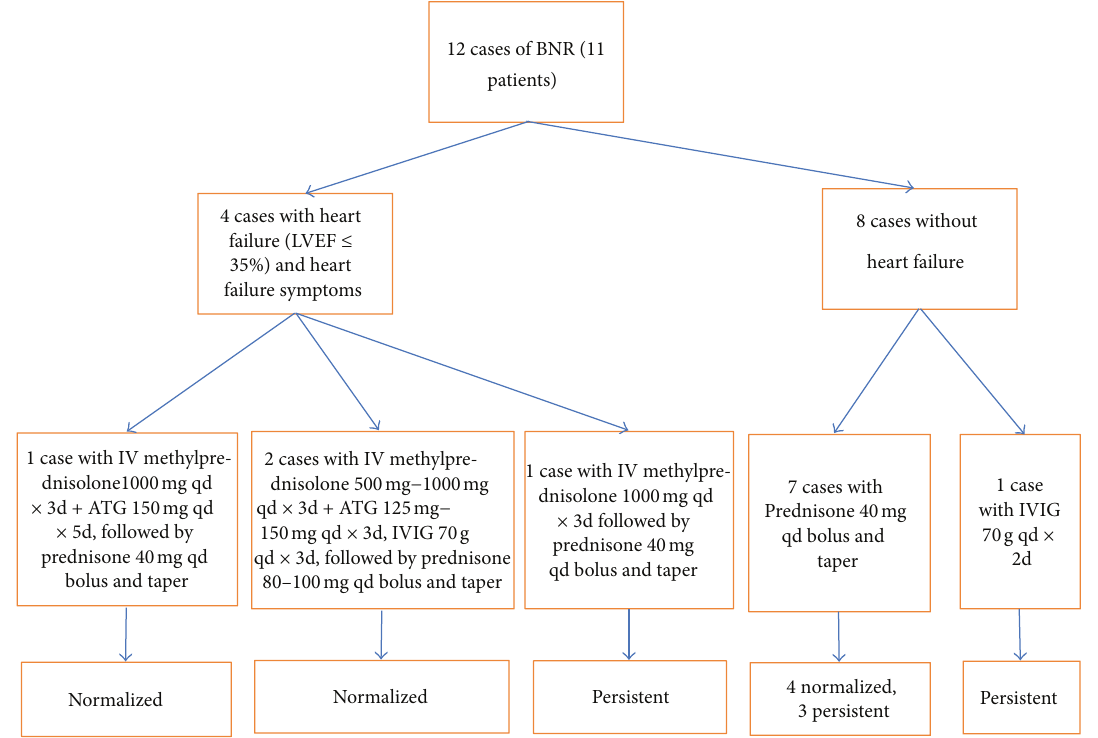
Figure 1: BNR treatment and effect flow